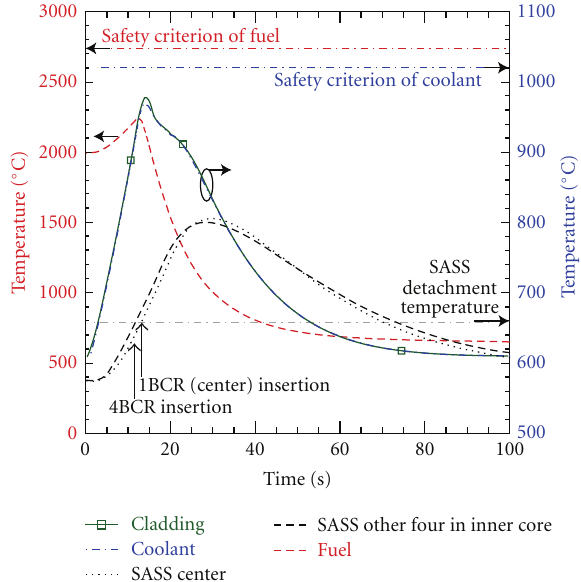
Figure 8: Loss-of-flow without scram accident with passive shut-